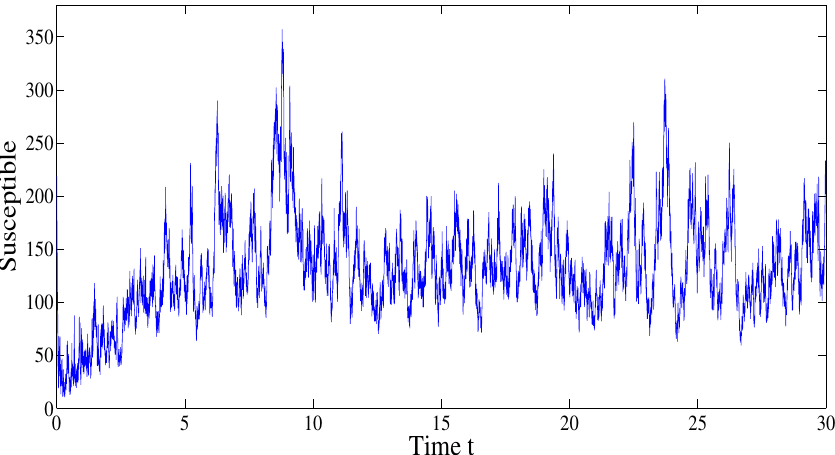
Figure 4. The susceptible and infected populations as functions of time when λ = 100, µ = 0.0013, β = 0.1, γ 2 = 1, γ 1 = 0.1, (cid:101) = 0.33, δ = 0.09 and d = 0.025.